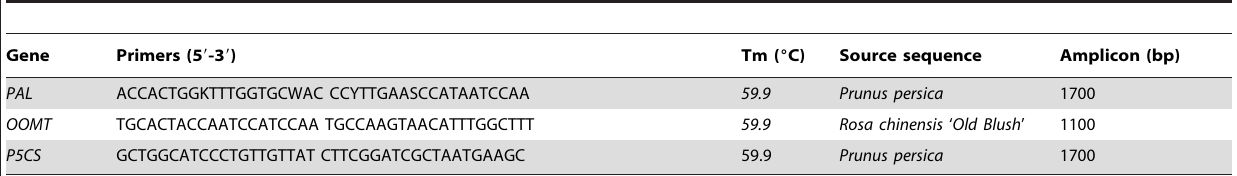
Table 1. Overview of the primers used to isolate the genes PAL (Phenylalanine Ammonia Lyase), OOMT (Orcinol O-Methyl Transferase) and P5CS (Pyrroline-5-Carboxylate